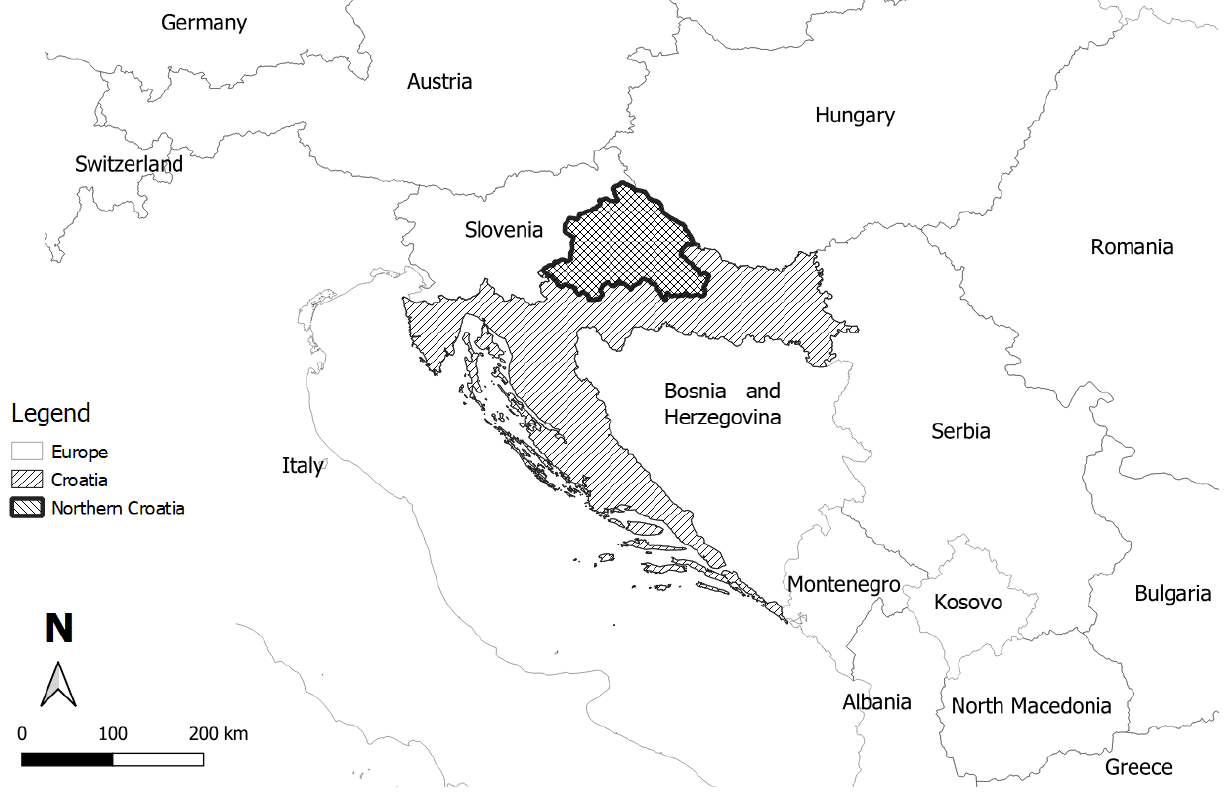
Figure 1. Case study—Northern Croatia.